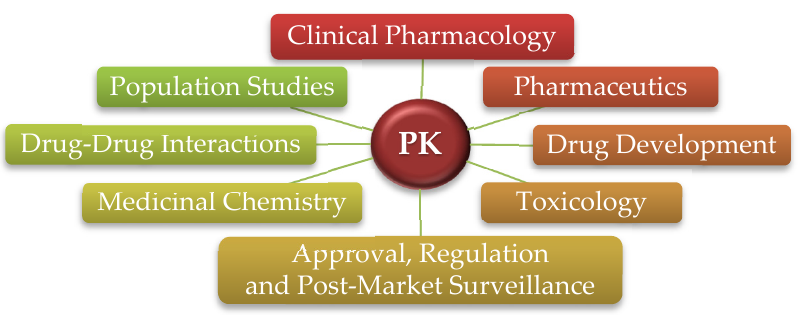
Figure 2. Diversity of applications of PK.